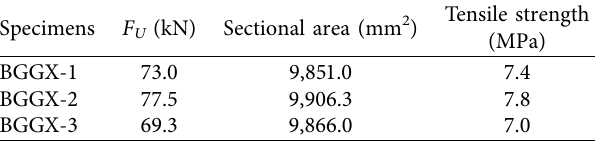
Figure 5: Four-point bending tests. (a) Specimen S1. (b) Specimen S2. (c) Specimen S3. Table 2: Tensile testing results.